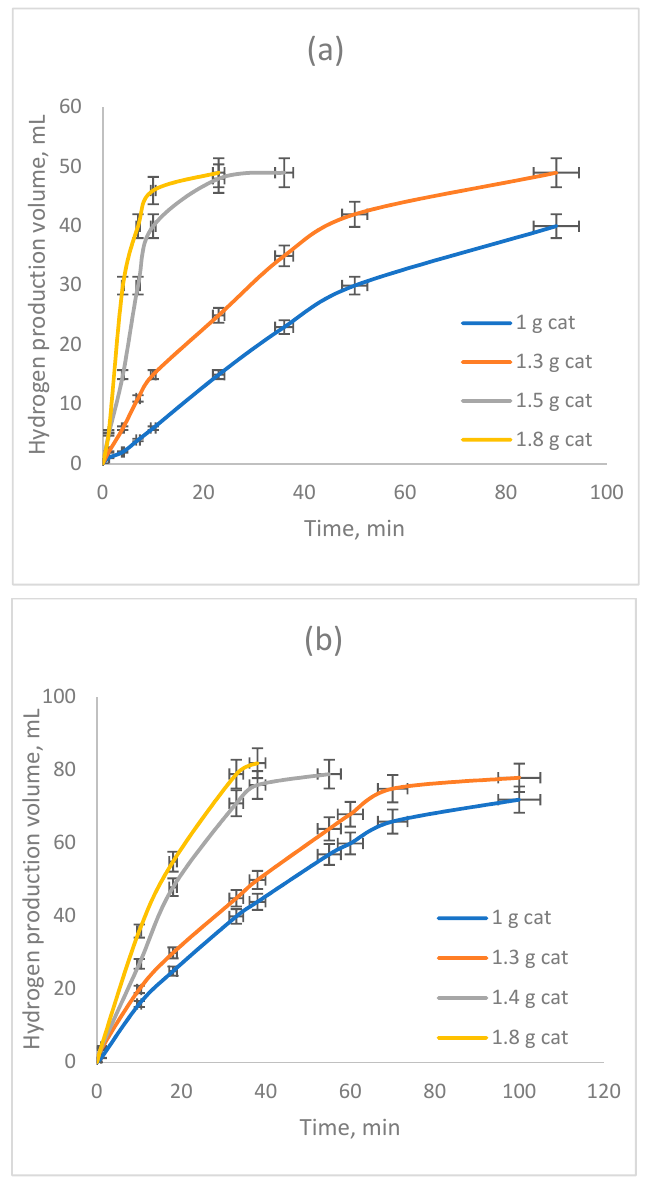
Figure 5. H 2 generation volume versus time over nickel catalyst varied amount of the catalyst. ( a ) DMAB experiments and ( b ) LiBH 4 experiments.